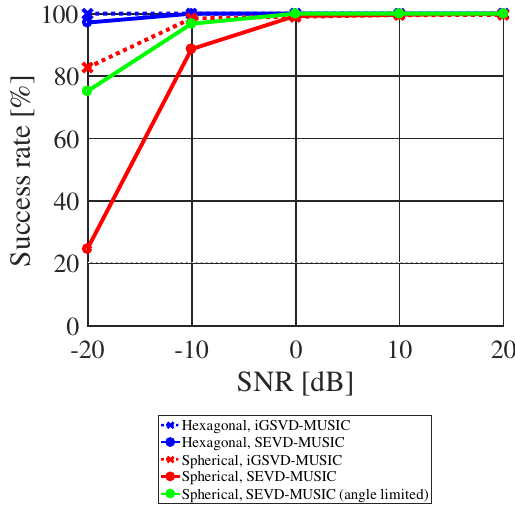
Figure 13. Success rate of